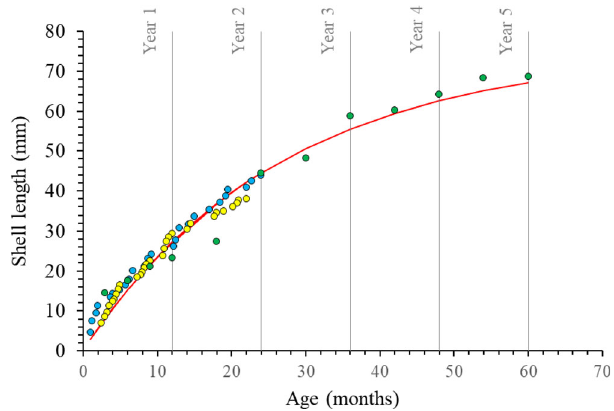
Fig. 6 Bertalanffy growth model of Cellana sandwicensis . Observed shell length-at-age measurements of Cellana sandwicensis (blue circles: modern CW1 shell; yellow circles: modern CW2 shell; green circles: historical BPBM shell) and the best fi t von Bertalanffy growth model from pooled measurements of all three shells (red line).